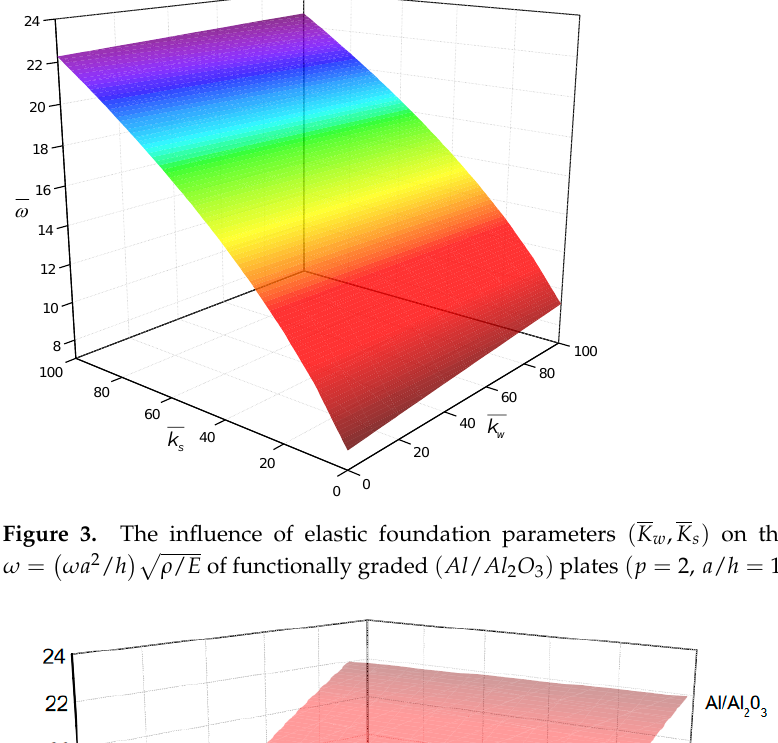
Figure 4. The variation in the natural frequency ω supported by elastic foundations ( p = 2, a / h = 10 ).